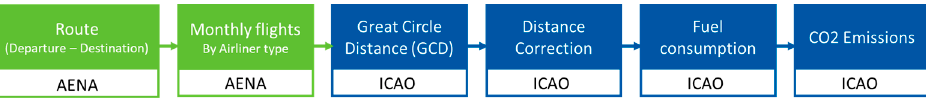
Figure 1. Block diagram for data set collection. Source: own compilation based on research sources according to Appendix A—Load Factors by Route Group from [20] (pp. 12–13), and Appendix C—ICAO Fuel Consumption Table from [20] (pp. 17–23).